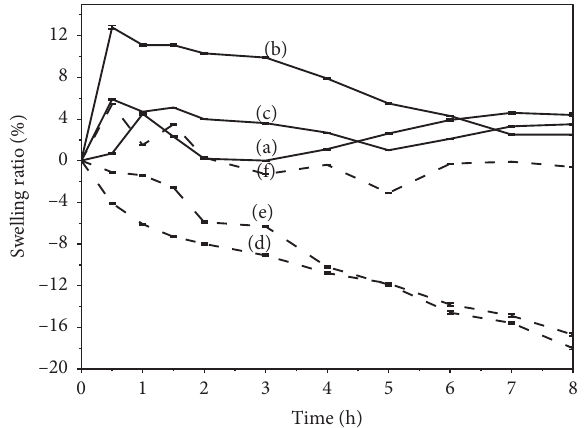
Figure 6: Swelling ratios in different pH values of CS@SA/chitosan nanocomposite hydrogels fabricated with different weight ratios of SA and CS at (a) pH=6.8, 1:1; (b) pH=6.8, 2 :1; (c) pH =6.8, 5:1; (d) pH=1.2, 1:1; (e) pH=1.2, 2:1; (f) pH =1.2, 5